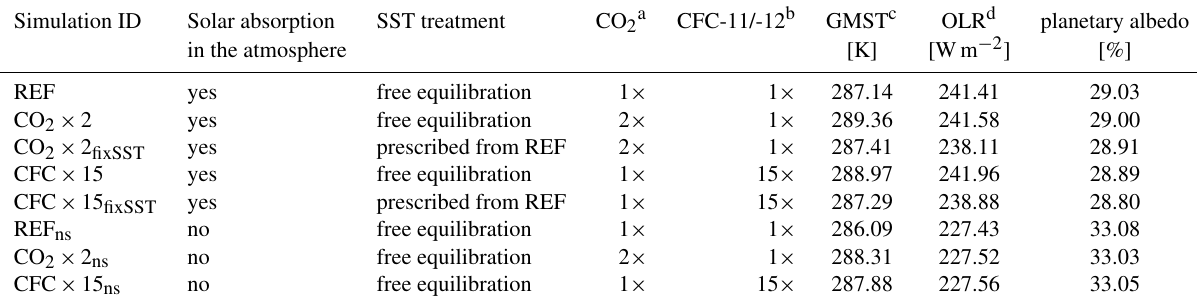
Table 1. ECHAM6 simulations. Simulation ID Solar absorption planetary albedo in the